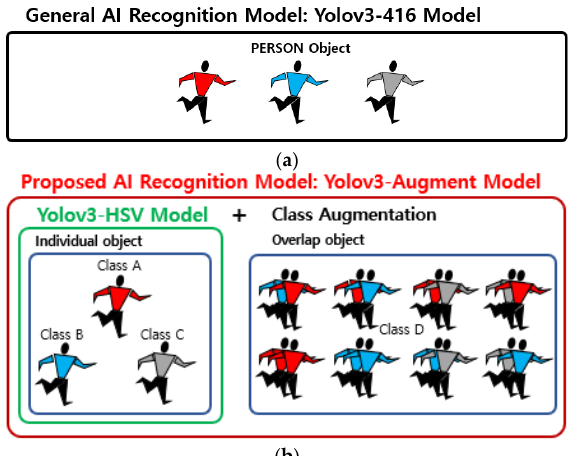
Figure 11. Recognition object type of AI Models; ( a ) Yolov3-416 model ( b ) Yolov3-Augment model.